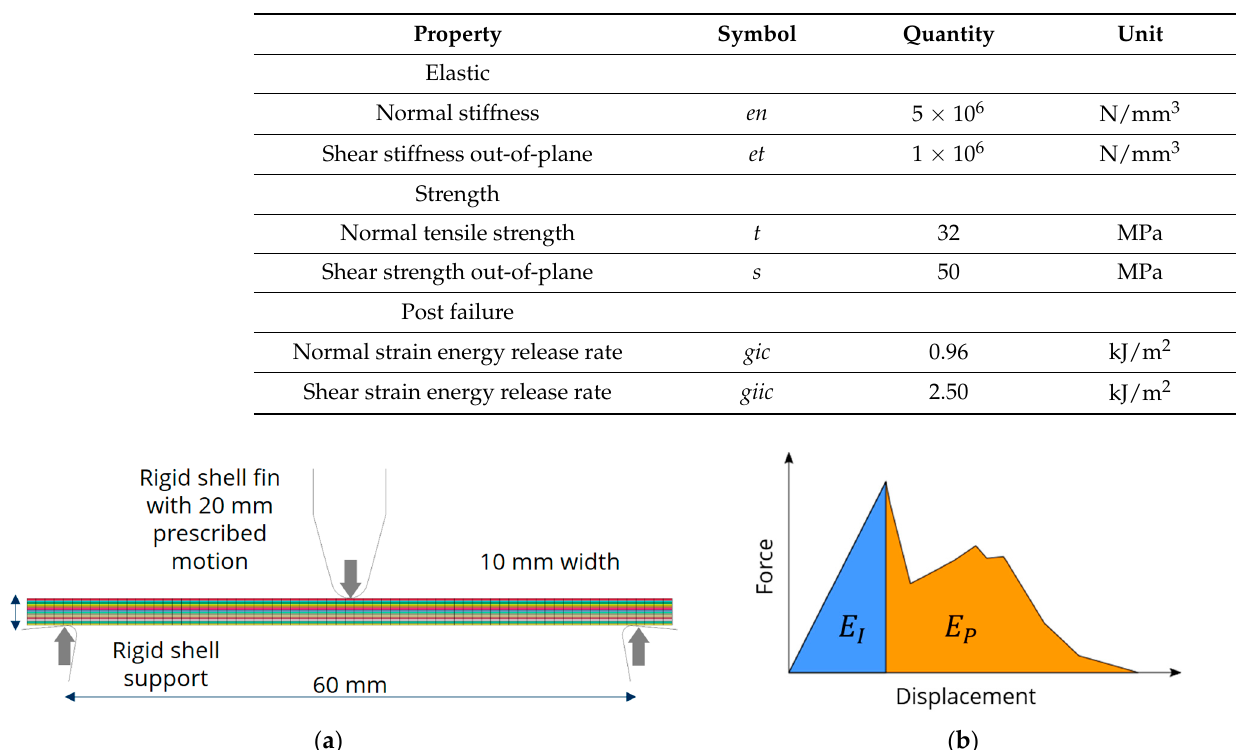
Table 2. Cohesive properties.